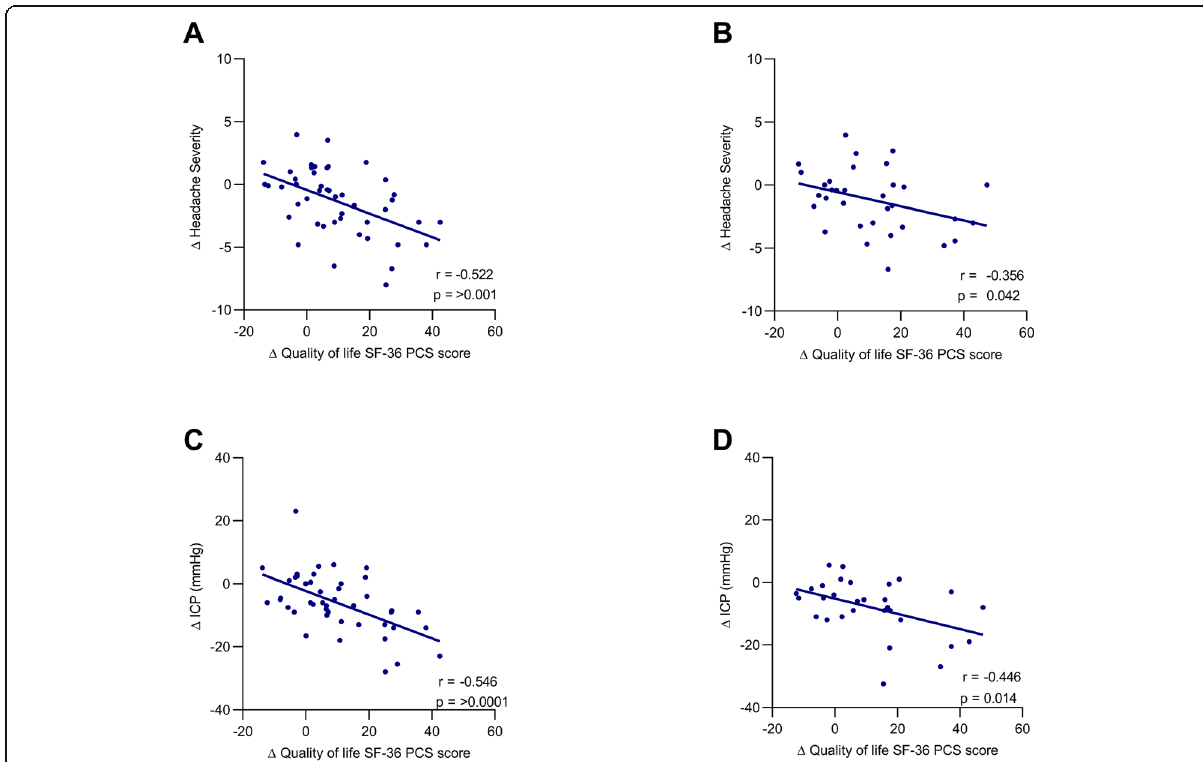
Fig. 3 Correlation of change in Quality of Life SF-36 physical component score (PCS) score and change in headache severity (HS) between baseline and 12 months ( A ) baseline and 24 months ( B ); Intracranial Pressure (ICP) between baseline and 12 months ( C ) between baseline and 24 months ( D